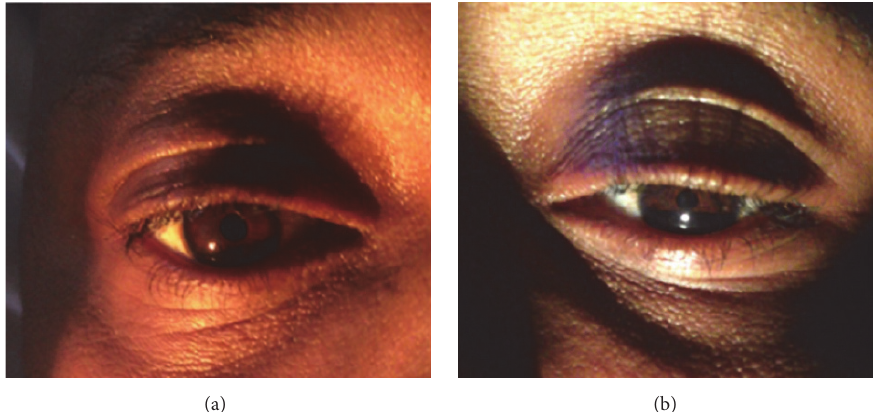
Figure 1: Patient with left Horner’s syndrome: normal right eye (a) and external examination in comparison to left eye (b) with ptosis, miosis, and